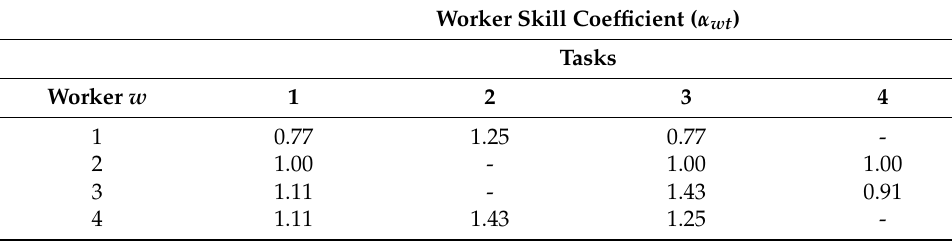
Table 3. Workforce skill coefficient for the example problem.